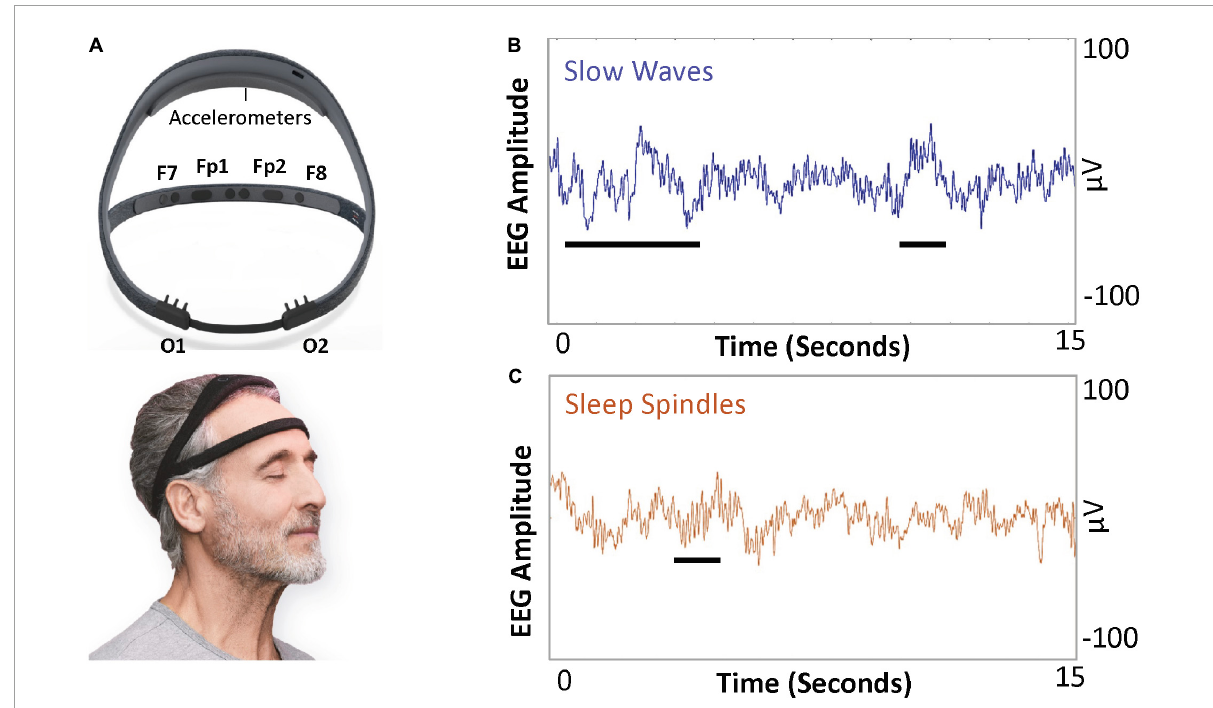
FIGURE1 Dreem device and example illustration of sleep slow wave activity (SWA) and spindles. (A) The Dreem device is a consumer-grade, wireless EEG device. The device has three frontal EEG channels, at F7, F8, and Fpz, and two occipital channels at O1 and O2. Both frontal and